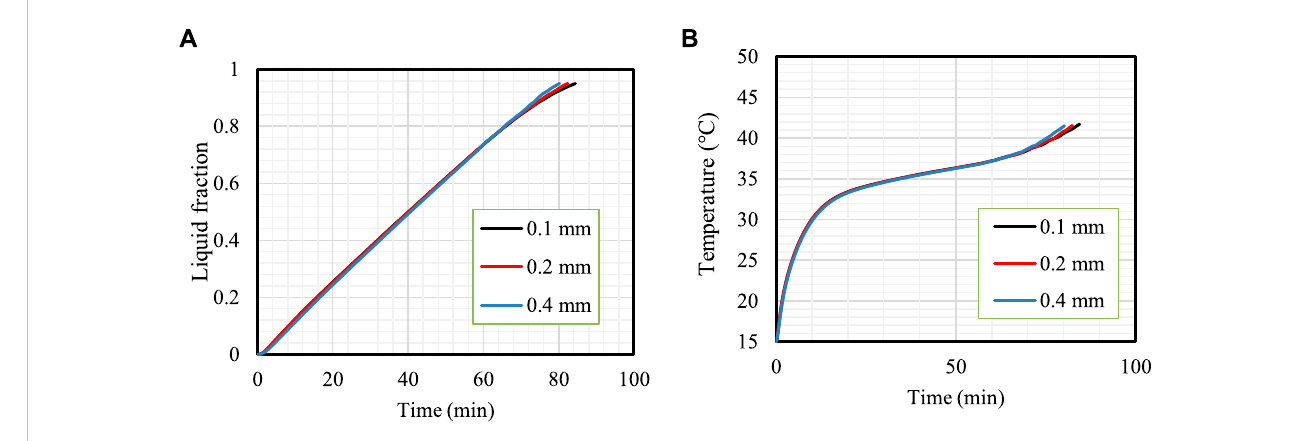
FIGURE 2 Mesh independence analysis. Variation in the liquid fraction (A) and mean temperature (B) for different mesh sizes.